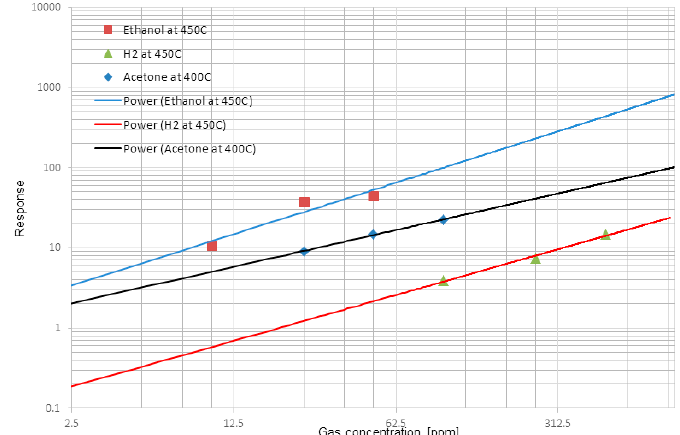
Figure 4. Response towards H 2 , Acetone and Ethanol in different working temperatures. RH = 40% at 20 °C with applied voltage equal to 1